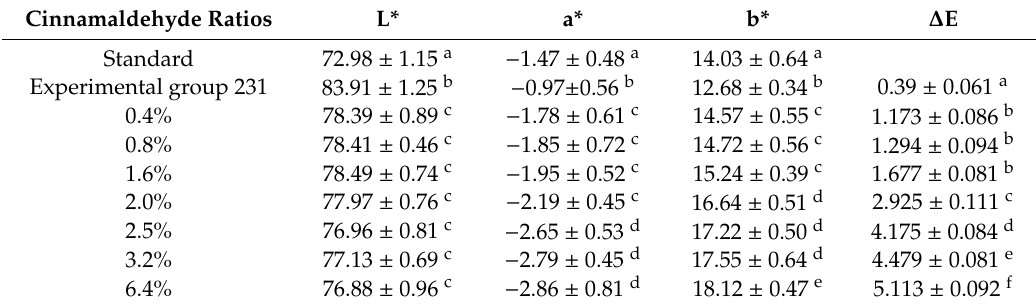
Color values of the chitosan (CS) / corn starch / cinnamaldehyde films with di ff erent cinnamaldehyde